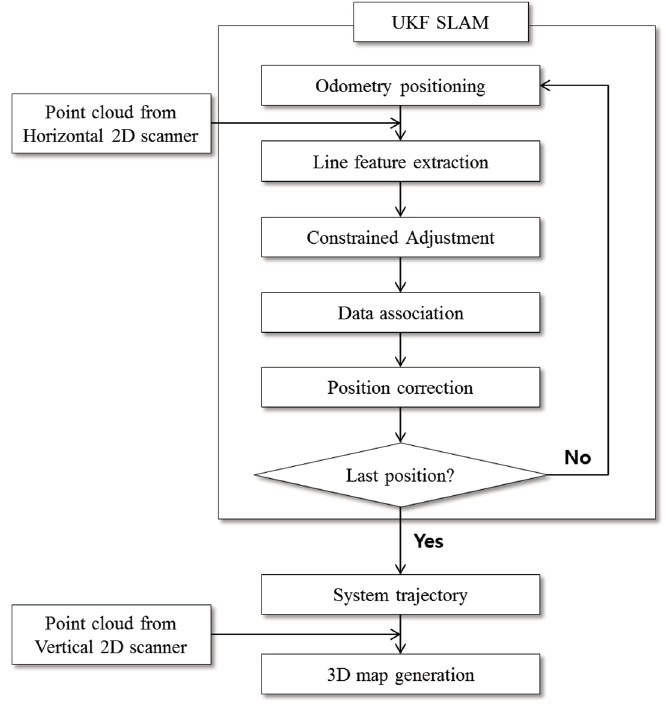
Figure 1. Study flow